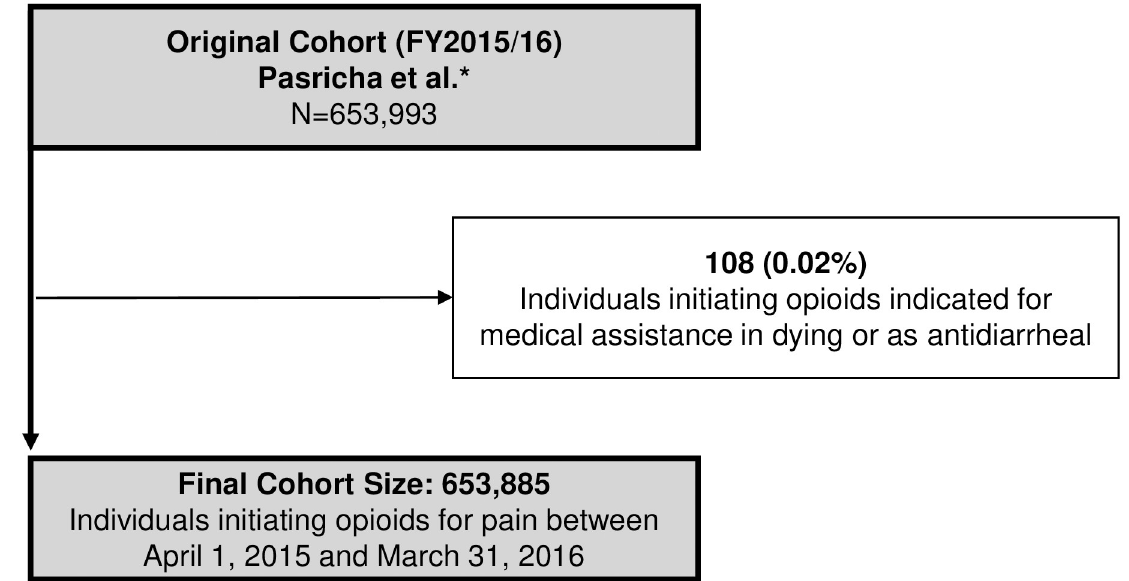
Fig 1. Cohort inclusion and exclusion criteria: Fiscal year 2015/16 cohort. Note that the antidiarrheal exclusion is noted here as it was not originally part of the exclusion criteria in Pasricha et al. and therefore required further exclusion for this analysis.